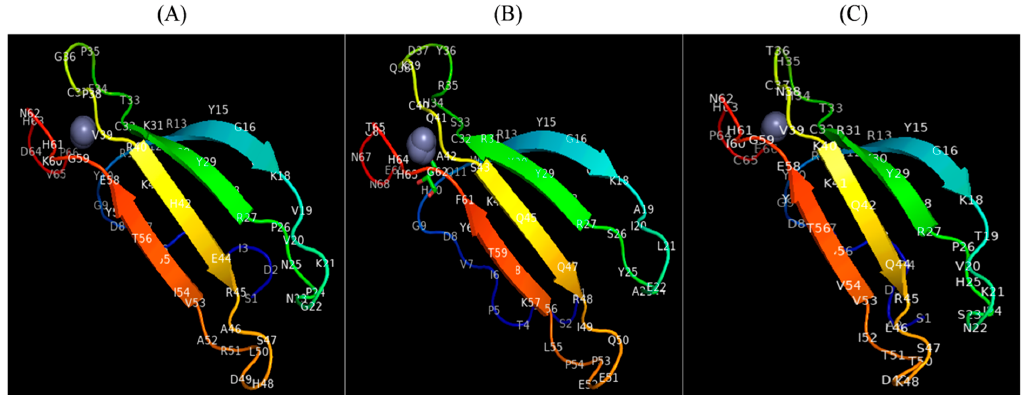
Figure 6. The homology-based tertiary structure of three WRKY proteins representative of three major groups of WRKY genes identified in pigeonpea genome. The protein structure of each of the three ( A ) CcWRKY1, ( B ) CcWRKY2 and ( C ) CcWRKY4 were modeled with greater than 90% confidence score. Potential active sites are shown in these structures.